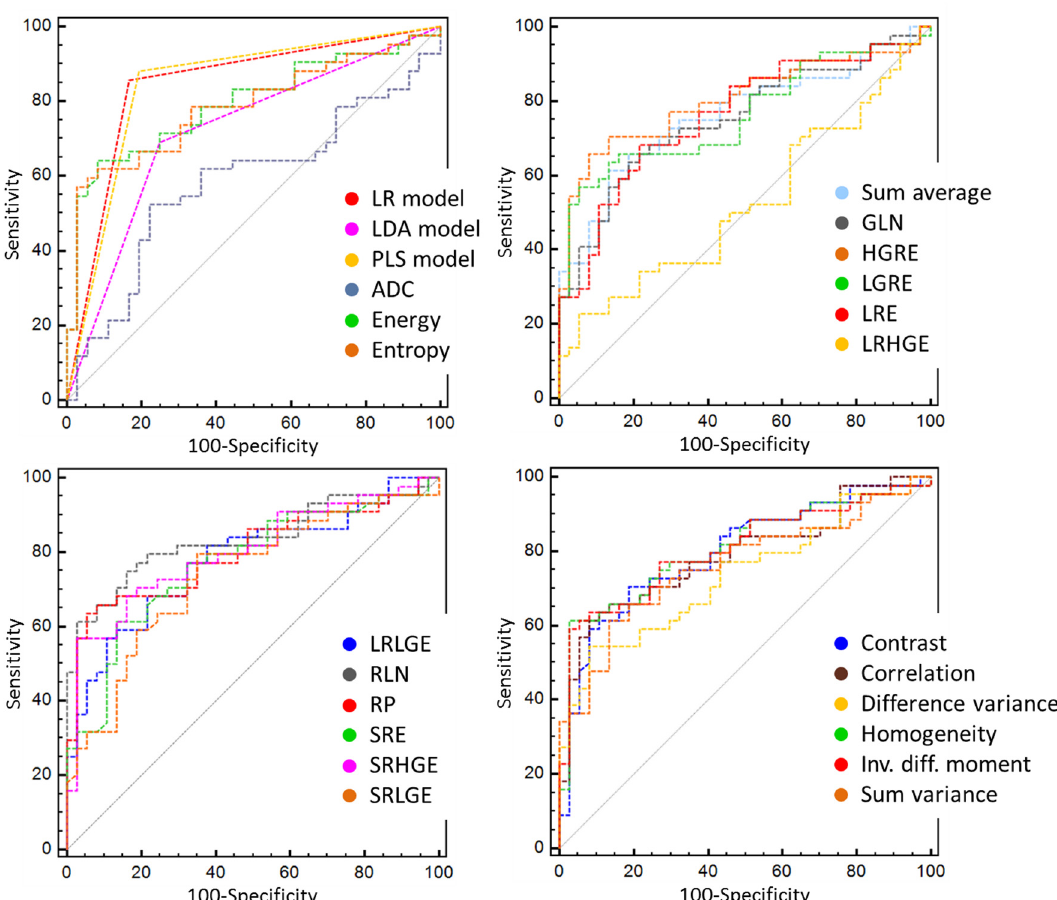
Fig 2. Receiver-Operating Characteristic analysis for evaluating the performance of individual parameters and multiparametric models in discriminating enhanced lesions from unhencanced lesions.